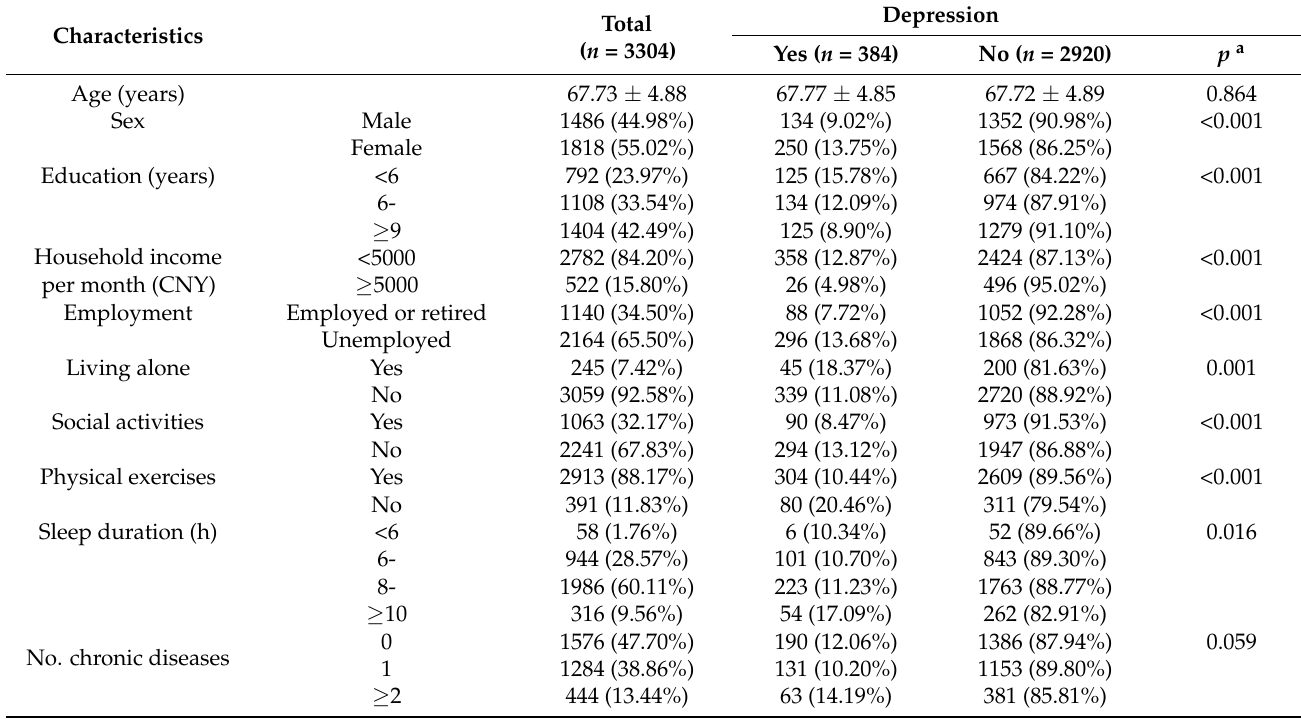
Table 2. Characteristics of participants with and without depression [Mean ± SD / n (%)].